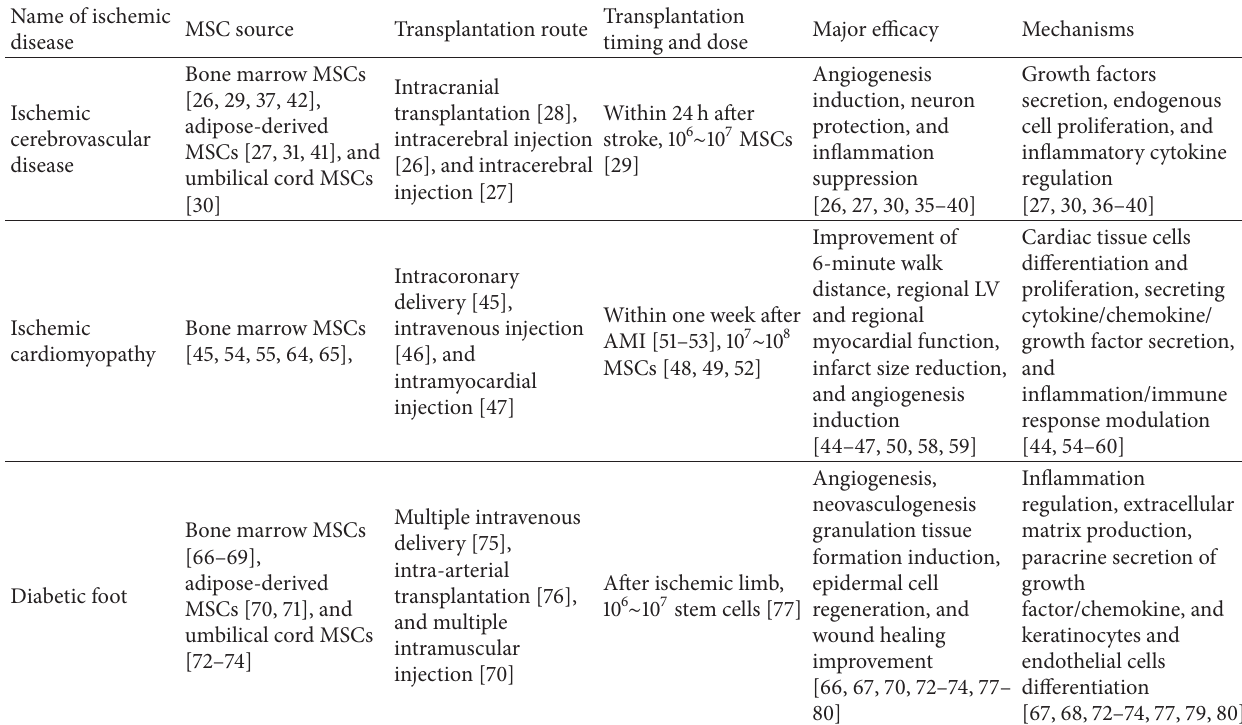
Table 1: Summary of important factors and efficacy of MSCs therapeutics for ischemic cerebrovascular disease, ischemic cardiomyopathy ICM, and diabetic foot from recent